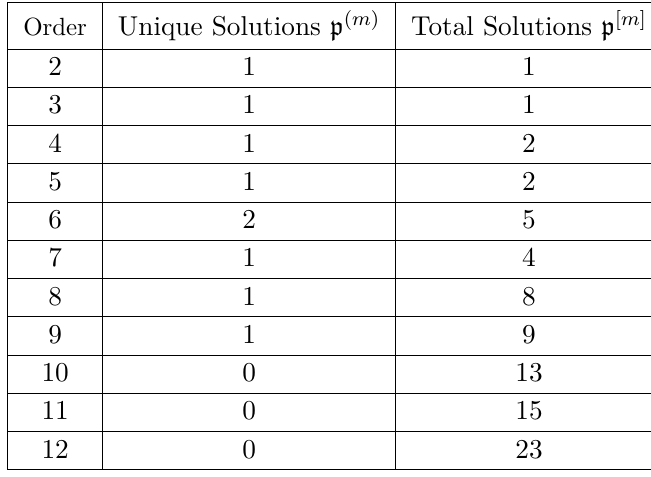
Table 3 . Total number of linearly-independent permutation-invariant scalar solutions, and number of unique solutions not spanned by products of lower-order solutions, at each order in momentum